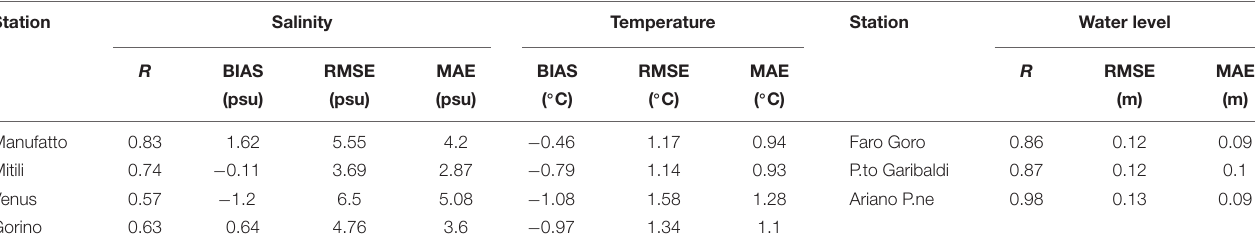
TABLE 1 | Statistical scores for temperature and salinity and water level, as defined in Appendix B .